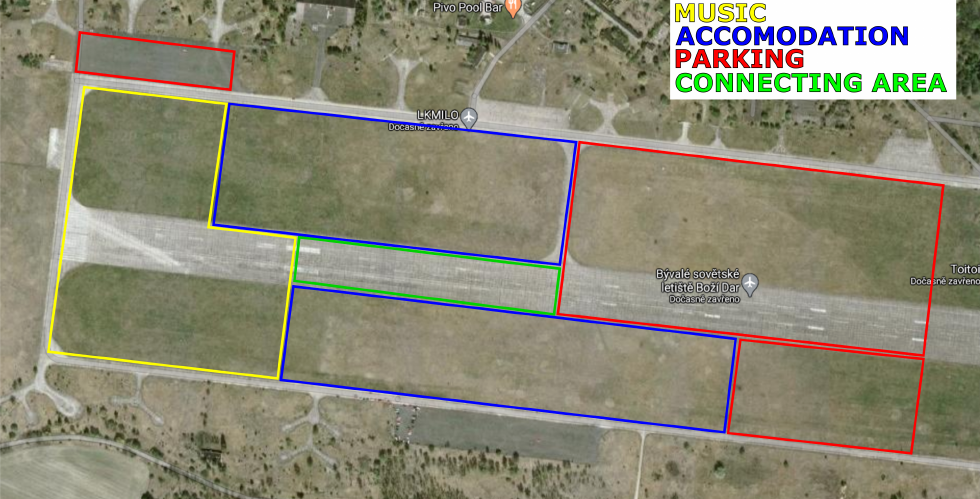
Figure 2. Real satellite photo of the airfield with marked subareas. Table 4. Subarea division with user densities.